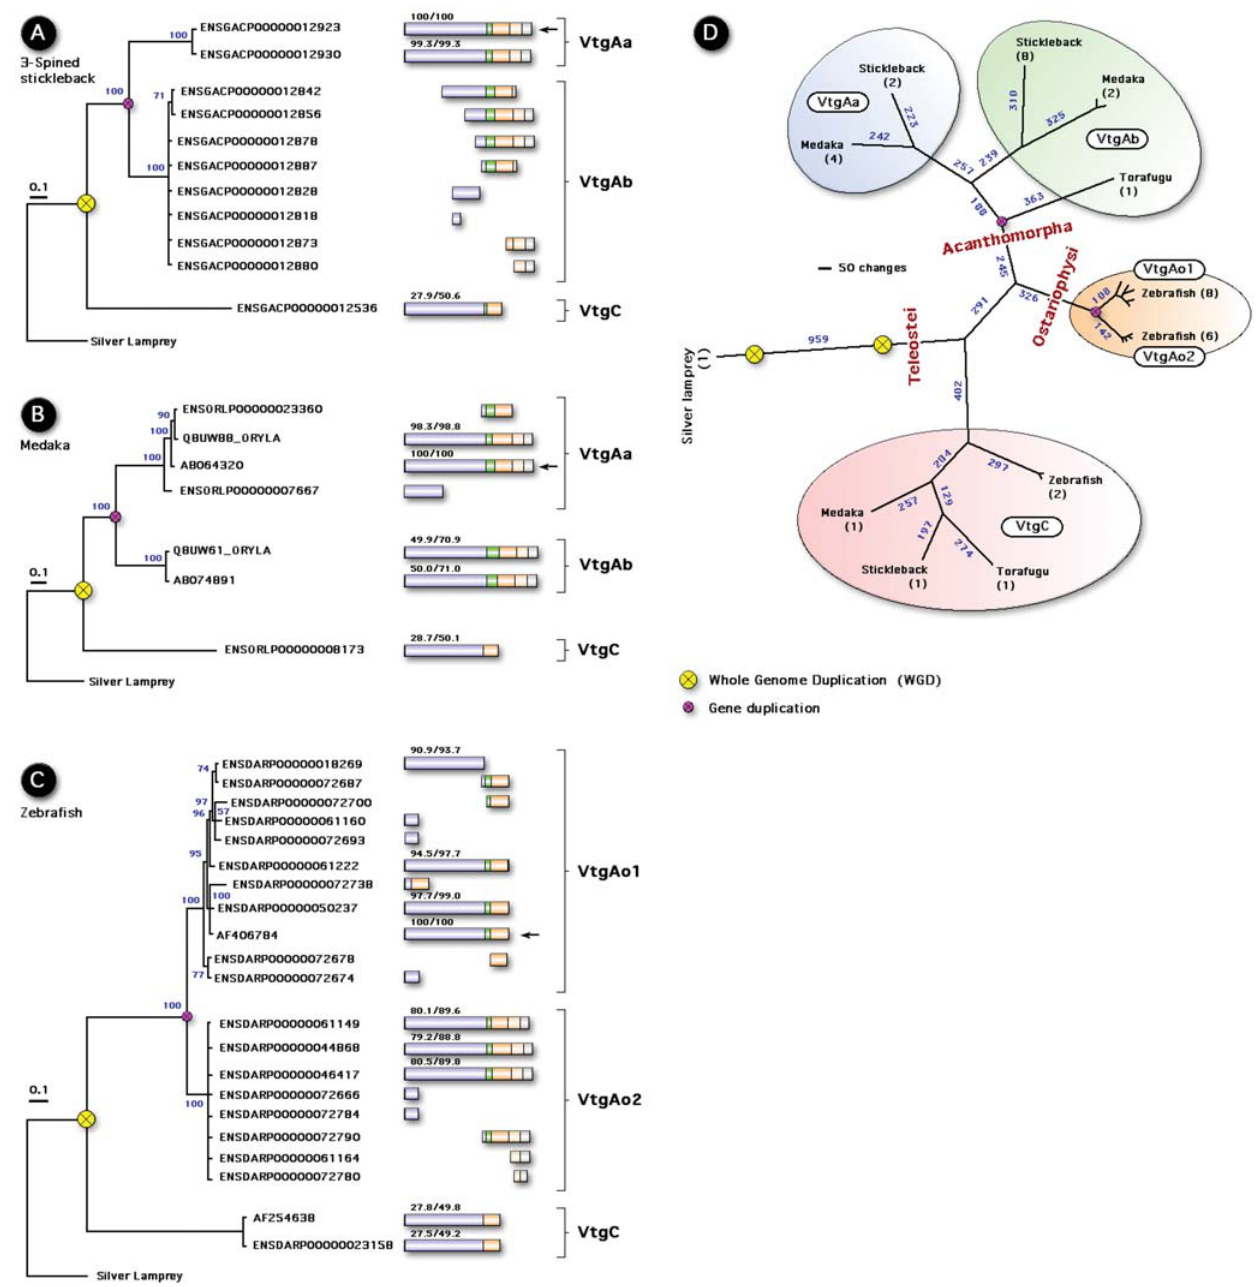
Figure 3. Bayesian majority rule consensus phylogenetic trees for the amino acid alignment of known and novel genomic vitellogenins. Panel A: 3- spined stickleback ( Gasterosteus aculeatus ); Panel B: Medaka ( Oryzias latipes ); Panel C: Zebrafish ( Danio rerio ) includes sequenced genes, and full genes ensembl release 38 and fragments from ensembl release 41; Panel D: Maximum parsimony phylogram of all known teleost genomic vitellogenin genes rooted with silver lamprey. The Vtg bars were constructed from conserved cleavage sites as described in Fig. 1. Homology identity and similarities for the full LvH domains are shown above each bar based on comparison to the reference sequence (arrow). See text and methods for further details of phylogentic